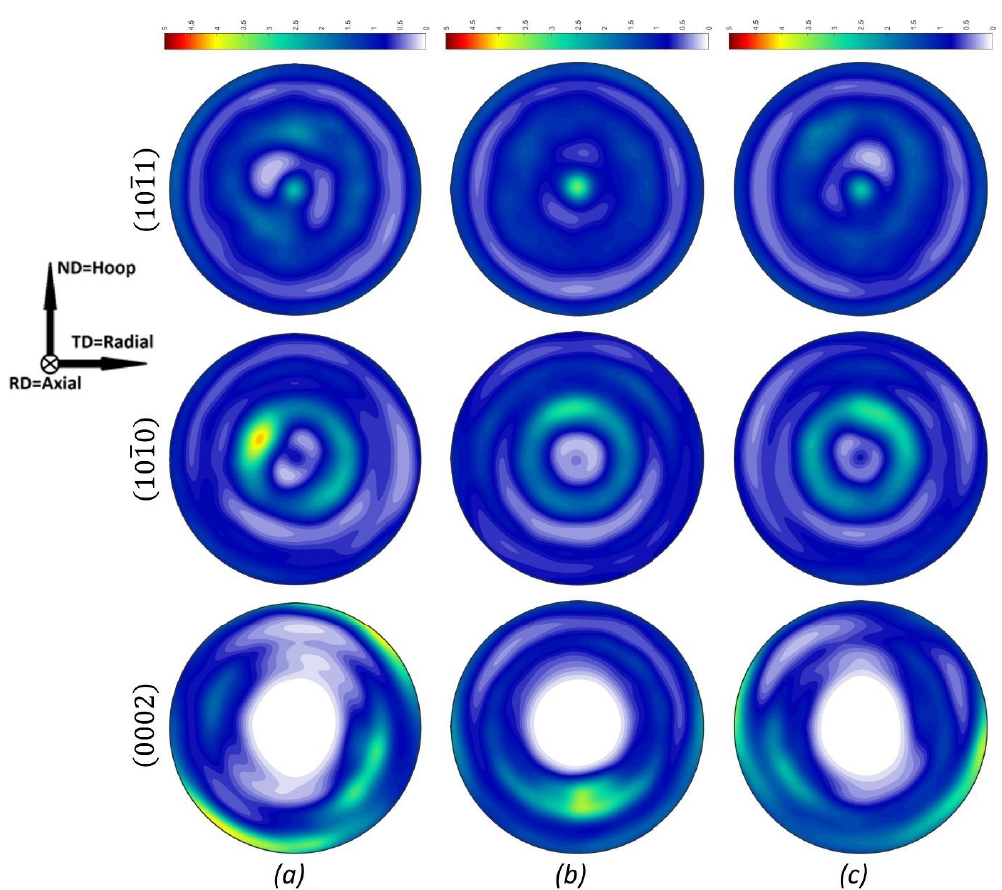
(cid:0) (cid:1) (cid:0) (cid:1) Figure 8. ( 0002 ) , 1010 , and 1011 pole figures after the first C-ECAP pass in the periphery ( a , c ), Figure 8. (0002) , (101̅0) , and (101̅1) pole figures after the first C-ECAP pass in the periphery ( a , c ), and in the central region ( b ) of the and in the central region ( b ) of the sample.